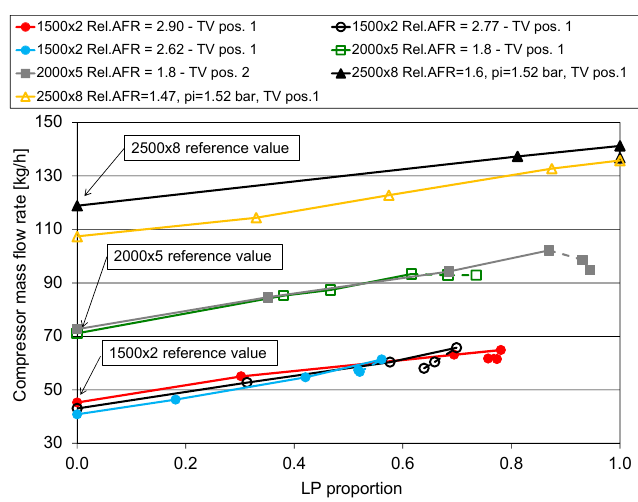
Figure 2. Compressor mass flow rate as a function of LP proportion in different operating modes.